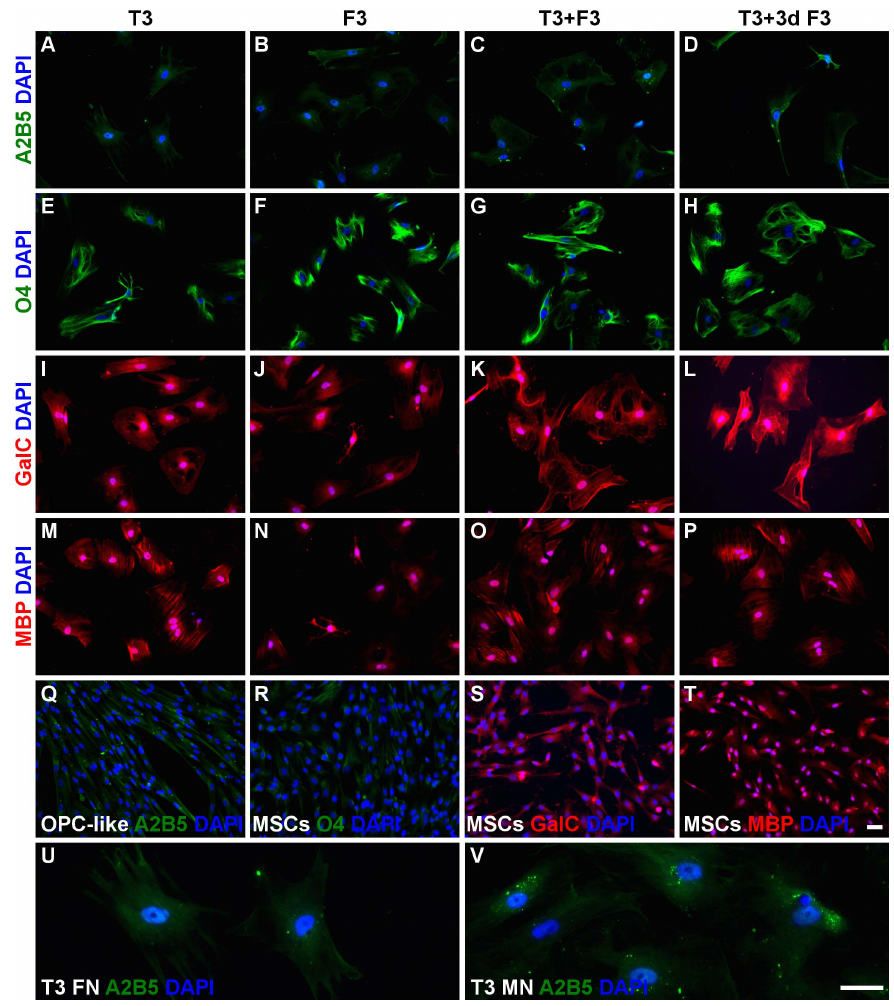
Figure 6. Expression of oligodendroglial markers by OL-like cells. The expression of the OPC marker A2B5 ( A-D ), the OPC/OL marker O4 ( E-H ) and the OL markers GalC ( I-L ) and MBP ( M-P ) in OL-like cells derived from OPC-like cells cultured on fibronectin was determined by immunofluorescence microscopy. OL-like cells were differentiated for 10 days on laminin 2 (merosin)-coated wells, in the presence of T3 (thyroid hormone), F3 (contactin), T3 + F3 or 7 days T3 followed by 3 days T3 + F3 (T3 + 3d F3), as indicated. It could be observed that the OPC marker A2B5 greatly decreased in the last stage of differentiation ( A-D ), as compared to OPC-like cells ( Q ), indicating maturation of the OL-like cells. The decrease was also more evident when OL-like cells were derived from OPC-like cells cultured on fibronectin (FN)-coated wells ( U ) than in laminin-2/merosin (LM/MN)-coated wells ( V ). The OPC/OL marker O4 was expressed at high levels in OL-like cells ( E-H ), in contrast to the low levels in hUCM-MSCs ( R ). The OL marker GalC was more highly expressed in OL-like cells ( I-L ) as compared to MSCs ( S ), while MBP seemed to be expressed ( M-P ) at similar levels ( T ). Counterstaining of nuclei was performed with DAPI (in blue) and the scale bars represent 50 m m - scale bar in image ( T ) is representative for images ( A-T ) and scale bar in image ( V ) is representative for images ( U-V ). Images are representative of at least 3 independent